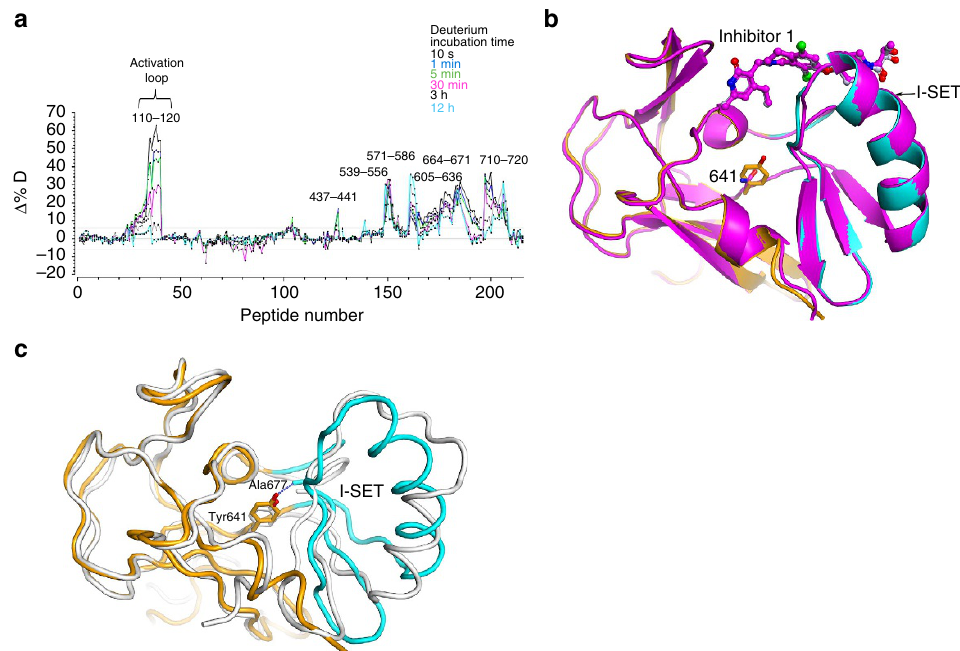
Figure 6 | Y641N and the EZH2 dynamics. ( a ) Differential (Y641N versus WT Ac EZH2 in the context of the crystallization constructs) deuterium uptake plots highlight increased dynamic nature of the C-terminal catalytic domain and the activation loop of Y641N Ac EZH2. Deuterium incubation times: 10s,1min, 5min, 30min, 3h and 12h. ( b ) Inhibitor-bound structures of the WT (orange with I-SET highlighted in cyan) and Y641N (magenta) PRC2 are essentially identical. For clarity, only the SETdomains bound to the inhibitor 1 are shown with the mutation site highlighted. ( c ) SETdomain from PRC2 is shown in orange, with I-SET (Gly643–Gly681) highlighted in cyan. Isolated SET domain (PDBID: 4MI5) is shown in grey. Tyr641 and Ala677 are sites of primary oncogenic mutations, at 3.5Å, in van der Waal’s contact with each other.